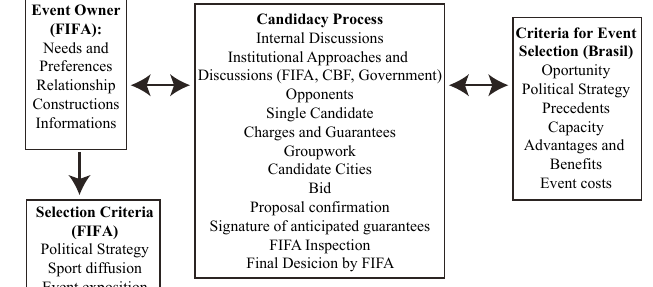
Figure 1. 2014 FIFA World Cup Candidacy